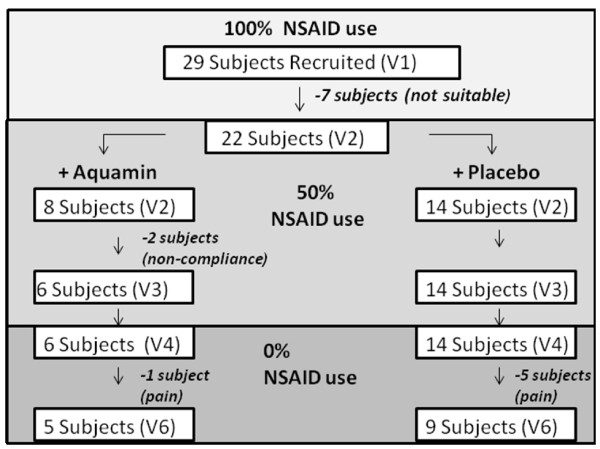
Trial flow chart.